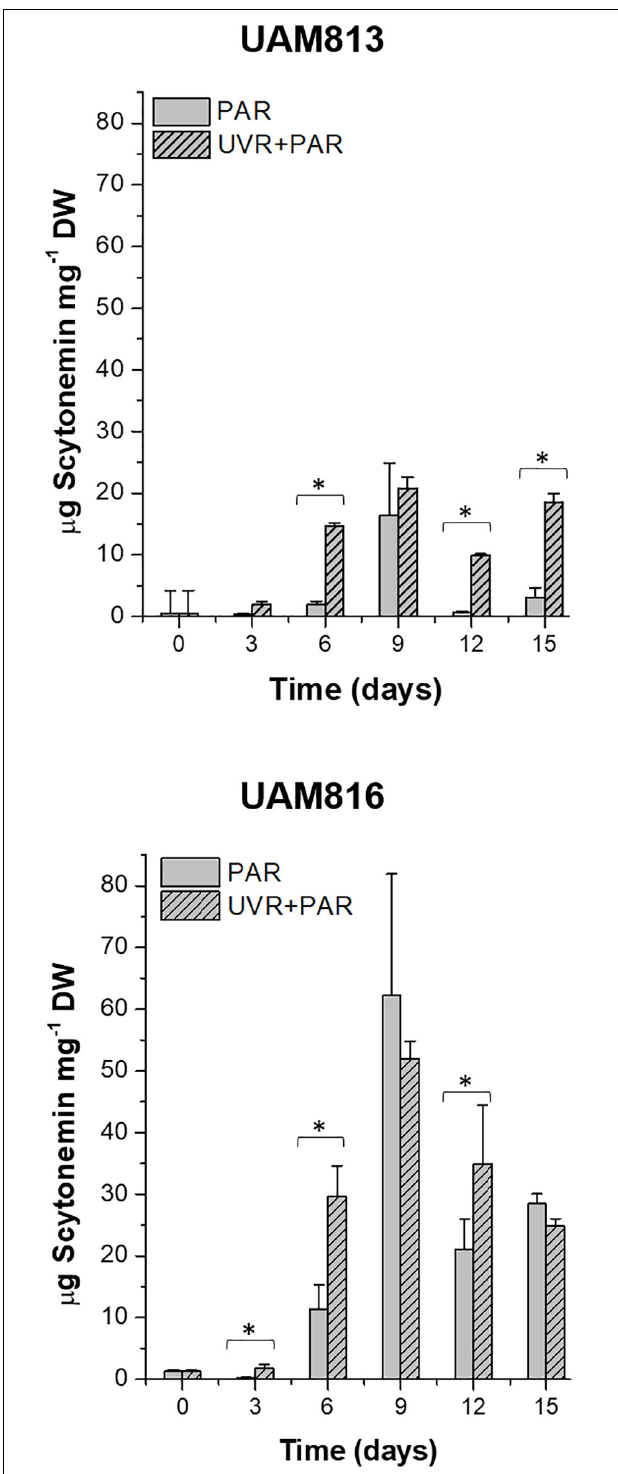
FIGURE 3 | Total scytonemin content, as quantified by HPLC, in UAM813 (upper graph) and UAM816 (lower graph) cells after irradiation with PAR (plain bars) or UVR + PAR (lined bars) for 15 days normalized to DW. Error bars indicate standard deviation. The asterisks indicate significant differences between light conditions at each timepoint ( t -test p <